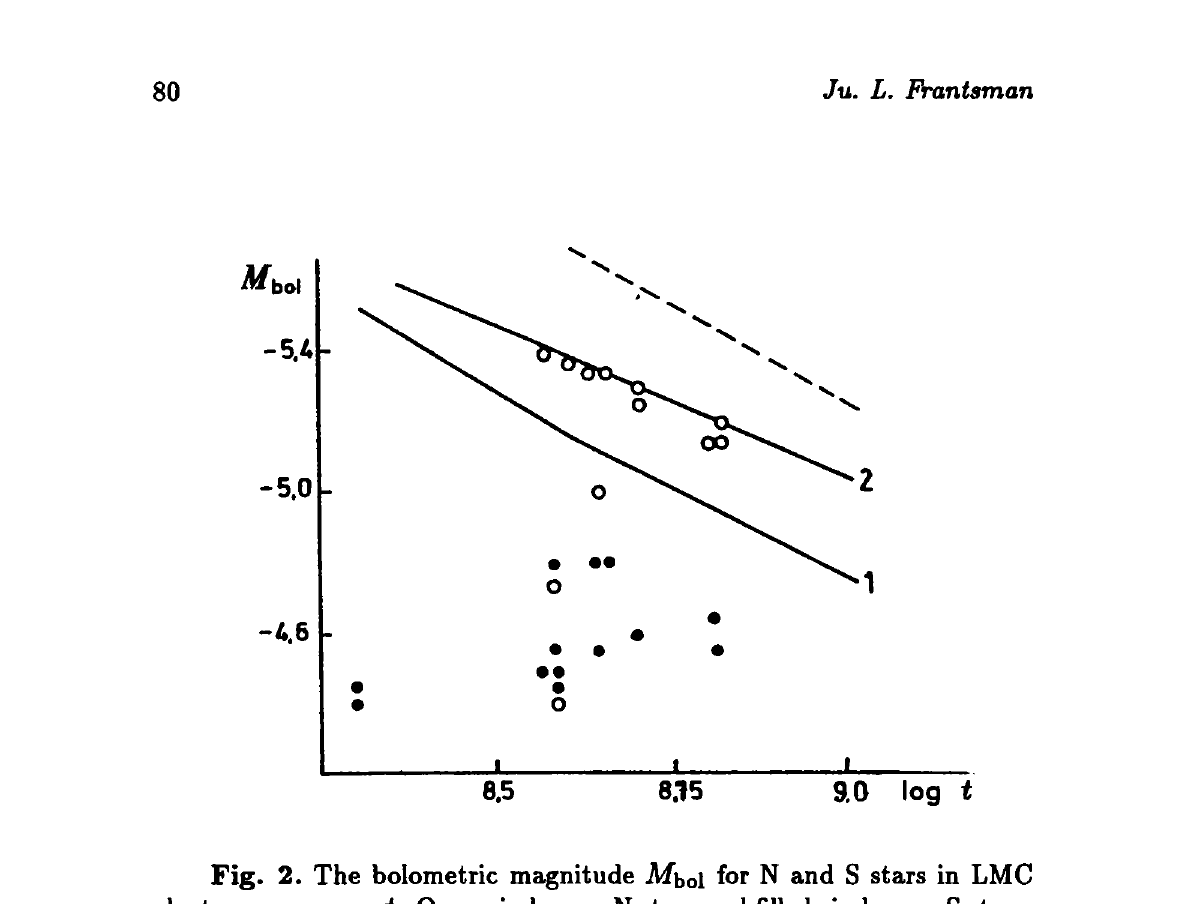
Fig. 2. The bolometric magnitude Mbol for Ν and S stars in LMC clusters versus age t. Open circles are Ν stars and filled circles are S stars. Solid line 1 shows the beginning of helium shell flash stage (TP-AGB), solid line 2 is the end of this stage assuming that the coefficient a in the Reimers mass-loss formula is chosen as in case I (see the caption for Fig. 1). The dashed curve shows the end of the TP-AGB stage if a =